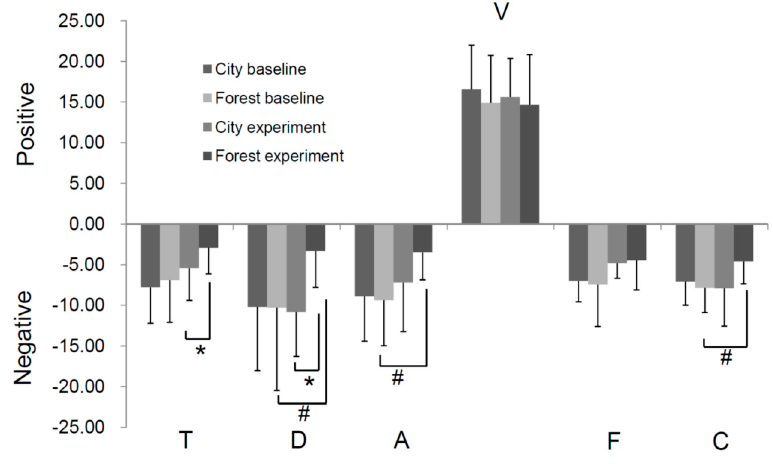
Figure 7. Profile of mood states (POMS) evaluation of subjects exposed to forest ( n = 23) or city environments ( n = 10). The standard version of POMS including negative subscales (T: tension-anxiety; D: depression-dejection; A: anger-hostility; F: fatigue-inertia; and C: confusion-bewilderment) and a positive subscale (V: vigor-activity) was used to evaluate the subjects’ mood changes before and after the experiment. * p < 0.05, # p < 0.05, analyzed by the Kruskal-Wallis test, followed by the Dunn-Bonferroni test.